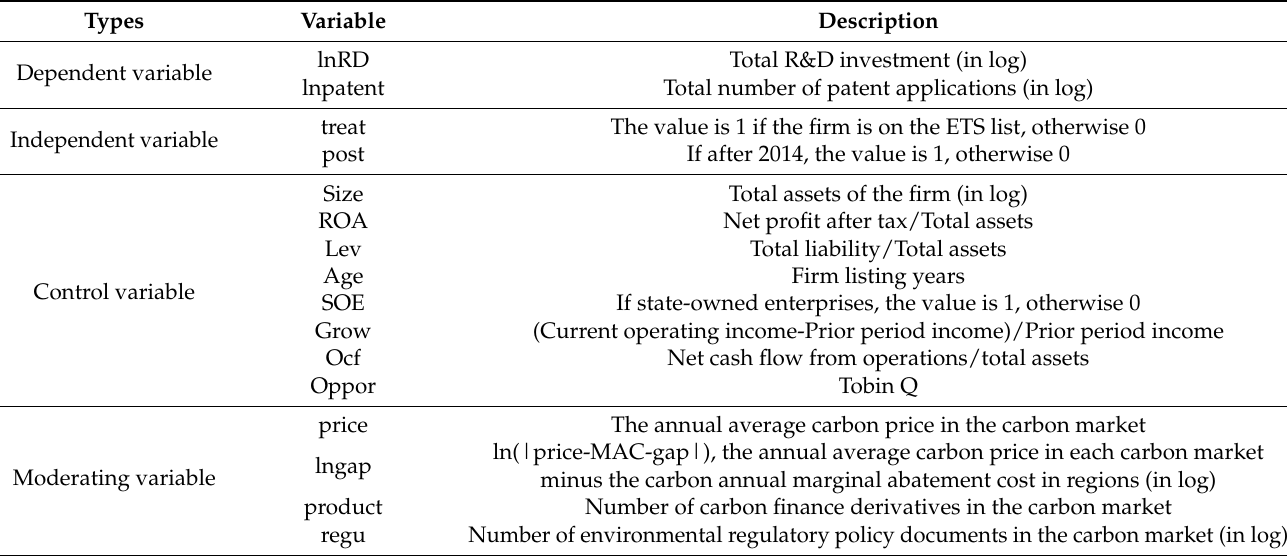
Table 1. Definition and description of main variables.